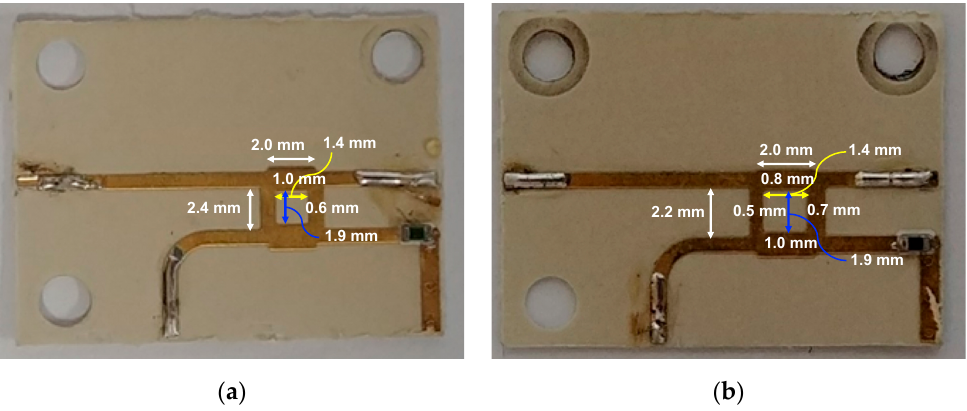
Figure 6. 24.125-GHz quasi-circulators fabricated on an RO3003 PCB: ( a ) conventional circulator; ( b ) proposed circulator.